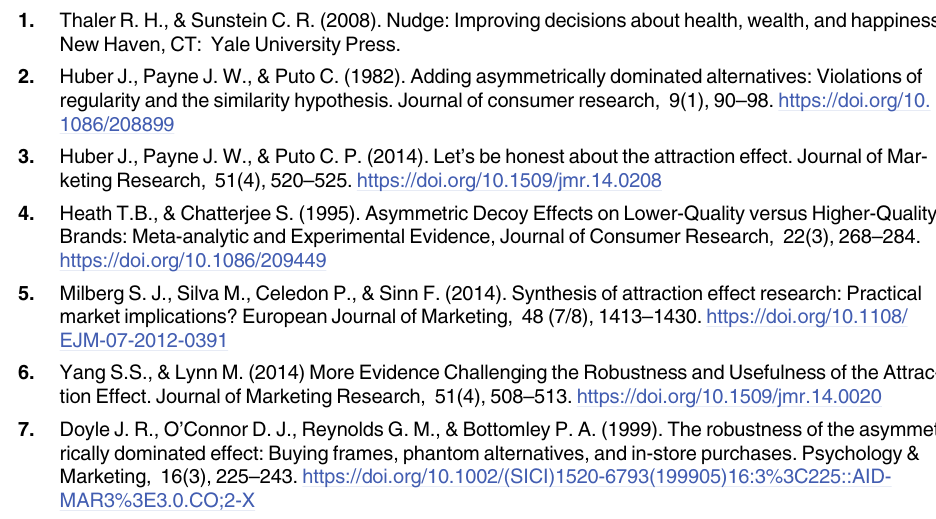
S4 Table. Descriptive statistics of the study population in Study 2. S5 Table. Multivariate regression models for Study 2. S1 Fig. Mean percentage of choosing the target hospital in Study 1. S2 Fig. Mean percentage of choosing the target hospital in Study 2. S3 Fig. Mean percentage of seeking more information in Study